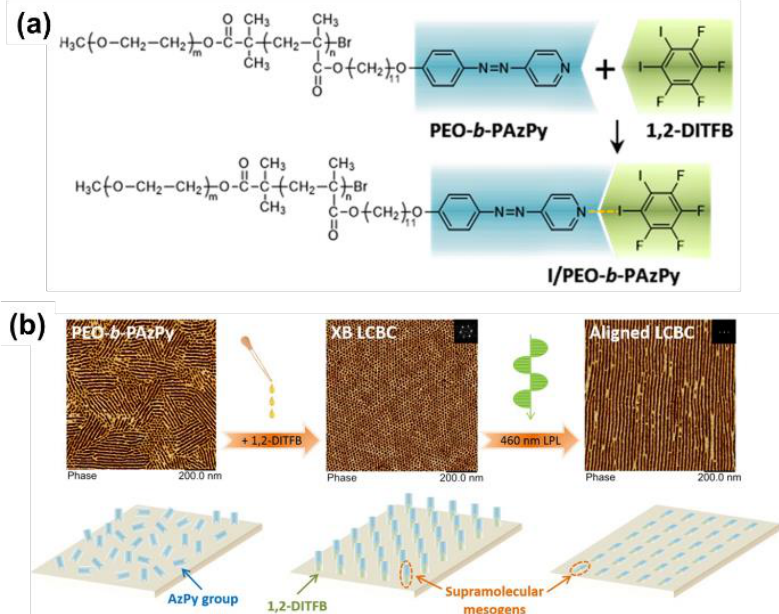
Figure 18. ( a ) Chemical structures of the 1:1 X-bond complex between PEO- b -PAzPy and 1,2- diiodo-3,4,5,6-tetrafluorobenzene (1,2-DITFB). ( b ) Photo-reorientation of supramolecular mesogens and ordered microphase separation nanostructures in the XB-involved supramolecular LCBC film. Reprinted with permission from [95]. Copyright 2020, American Chemical